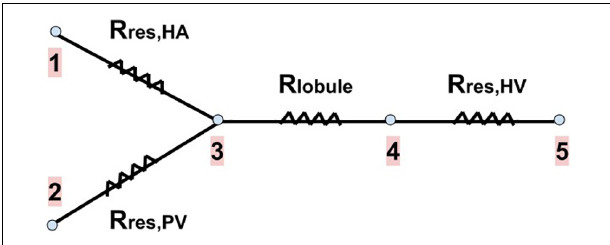
FIGURE 4 | Blood flow pathway with the resistances associated to each part of our vascular liver model. The two branches on the left of the drawing represent the blood supply networks to the liver (the HA and PV networks), the next branch represents a lobule (the blood received from the supply networks is evenly distributed among the lobules), and the last branch represents the HV network (in which blood is collected from all lobules to drain the liver). R res , HA , R res , PV and R res , HV are the new resistances of the networks after resection. R lobule is the resistance of a lobule (no change due to resection). Points 1 and 2 represent the inputs of the HA and PV networks, respectively. Point 3 represents the exit of these networks, as well as the entrance to each lobule. Point 4 represents the exit of each lobule and the entrance to the HV network. Point 5 represents the outlet of the HV network, that is, the outlet of the liver (the inferior vena cava,